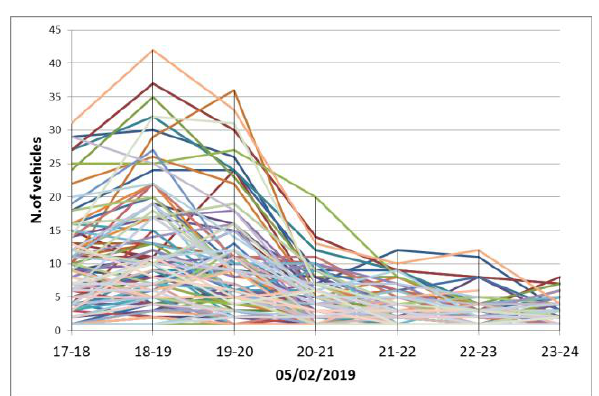
Figure 6. Traffic profiles derived from 5t fixed sensors